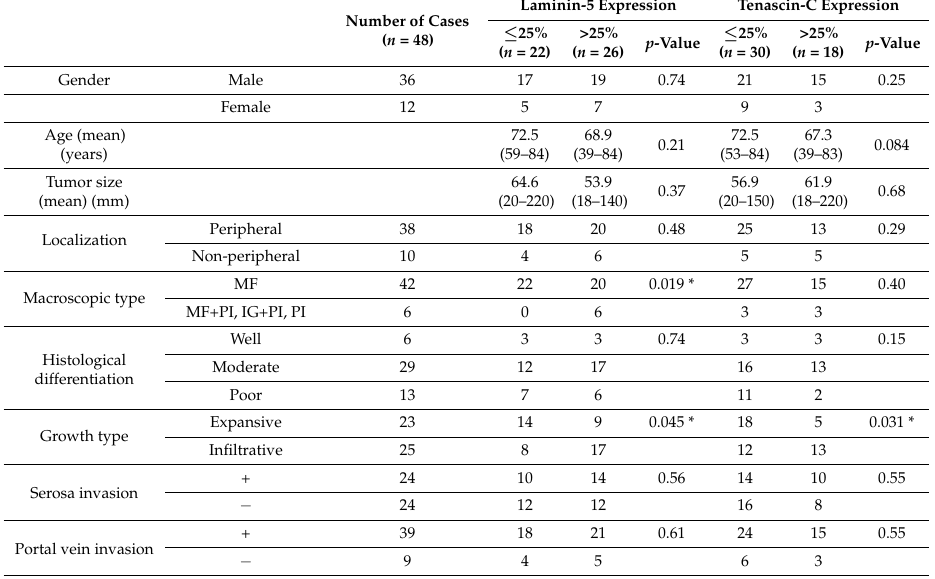
Correlation between laminin-5 and tenascin-C expressions and clinicopathological characteristics in intrahepatic